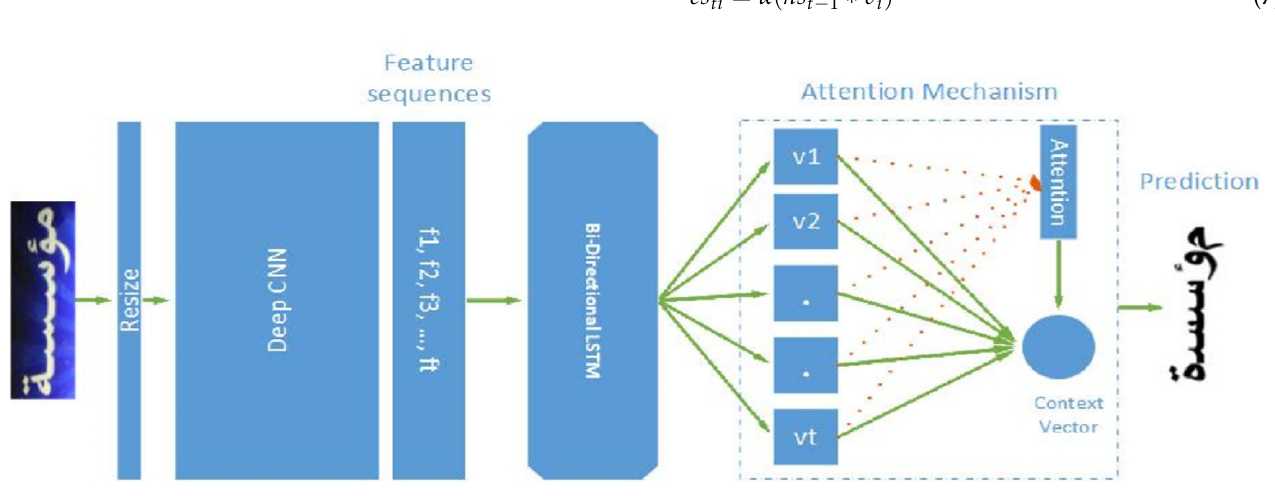
Figure 4. Proposed system model.